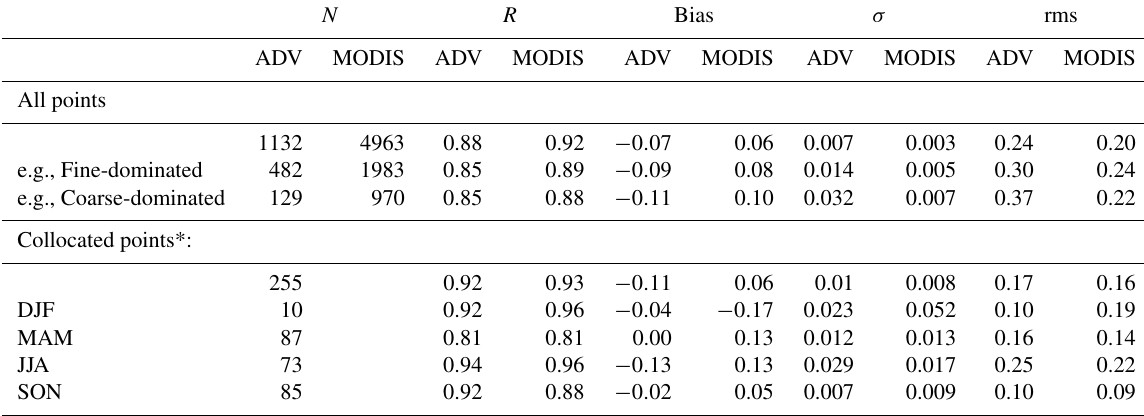
Table 1. ADV and MODIS AOD validation results over China for the 2000–2011 overlap period. Statistics (number of points – N , correlation coefficient – R , bias, standard deviation – σ and root mean square error – rms) for all validation points, separated by “fine-dominated” (AOD > 0 . 2, AE > 1) and “coarse-dominated” (AOD > 0 . 2, AE < 1) aerosols, and collocated points (*when ADV and MODIS overpasses are within ± 90min of each other and ADV, MODIS and AERONET retrieve AOD). For collocated points, statistics are also aggregated seasonally for winter (DJF), spring (MAM), summer (JJA) and autumn (SON).